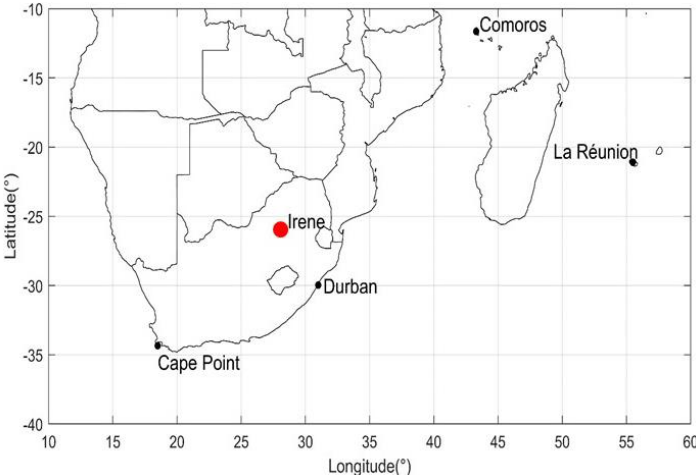
Figure 1. Geographical location of the Irene site (red symbol), a subtropical site in the southern hemisphere.